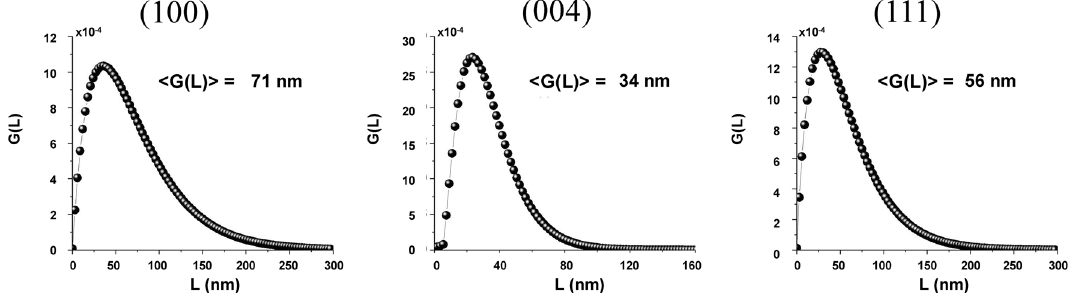
Figure 5. Volume-weighted crystallite size distribution G(L) for selected reflections of SFO ((100), (004)) and CFO (111) in the nanocomposite; for comparison corresponding Rietveld analysis values were respectively 70(7), 45(6) and 67(5) nm 6